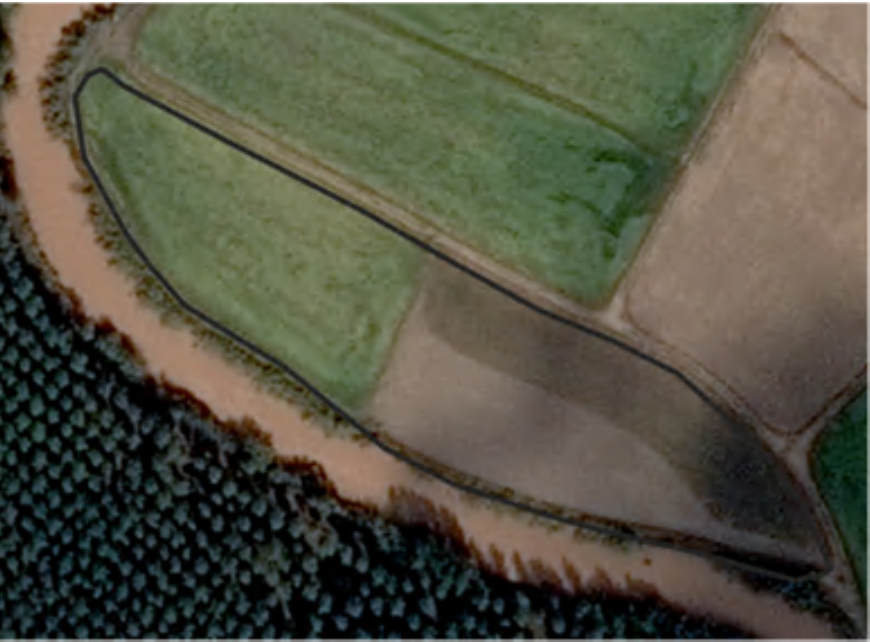
Figure 18. Parcel suspected of failing to comply with the conditions of the aid